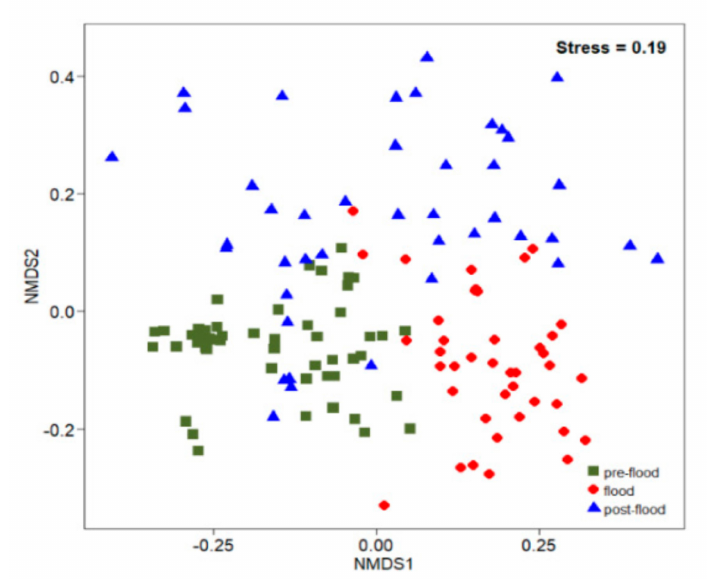
Figure 5. Ordering resulting from the analysis of non-metric multidimensional scaling (NMDS) on the density of ichthyoplankton based on Euclidean distance at the Laibin section of Xijiang in the summer of